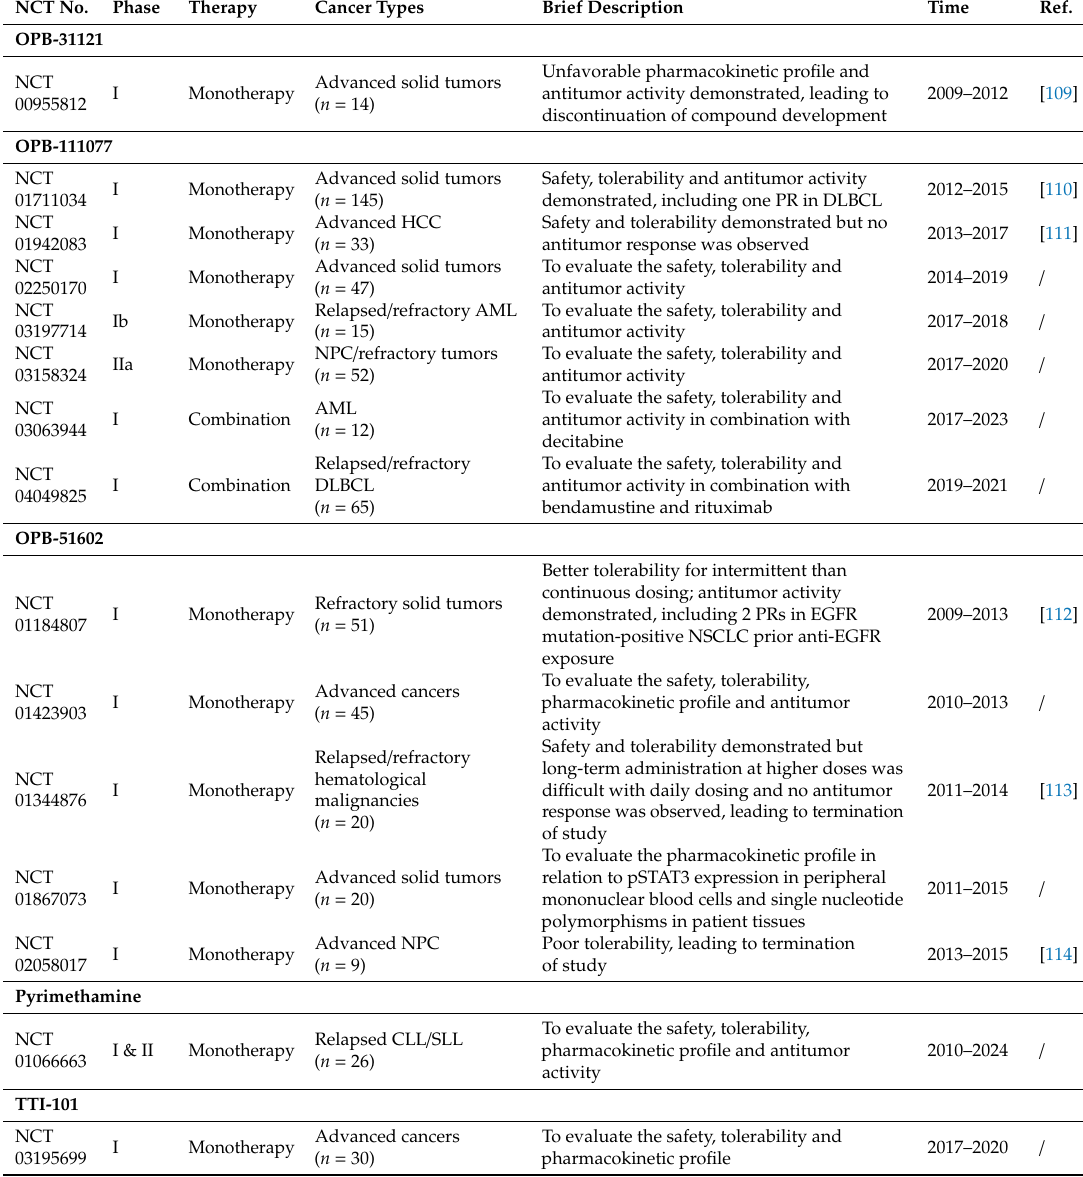
Table 3. Clinical trials of OPB compounds, pyrimethamine, TTI-101: STAT3 SH2 domain inhibitors. NCT No.